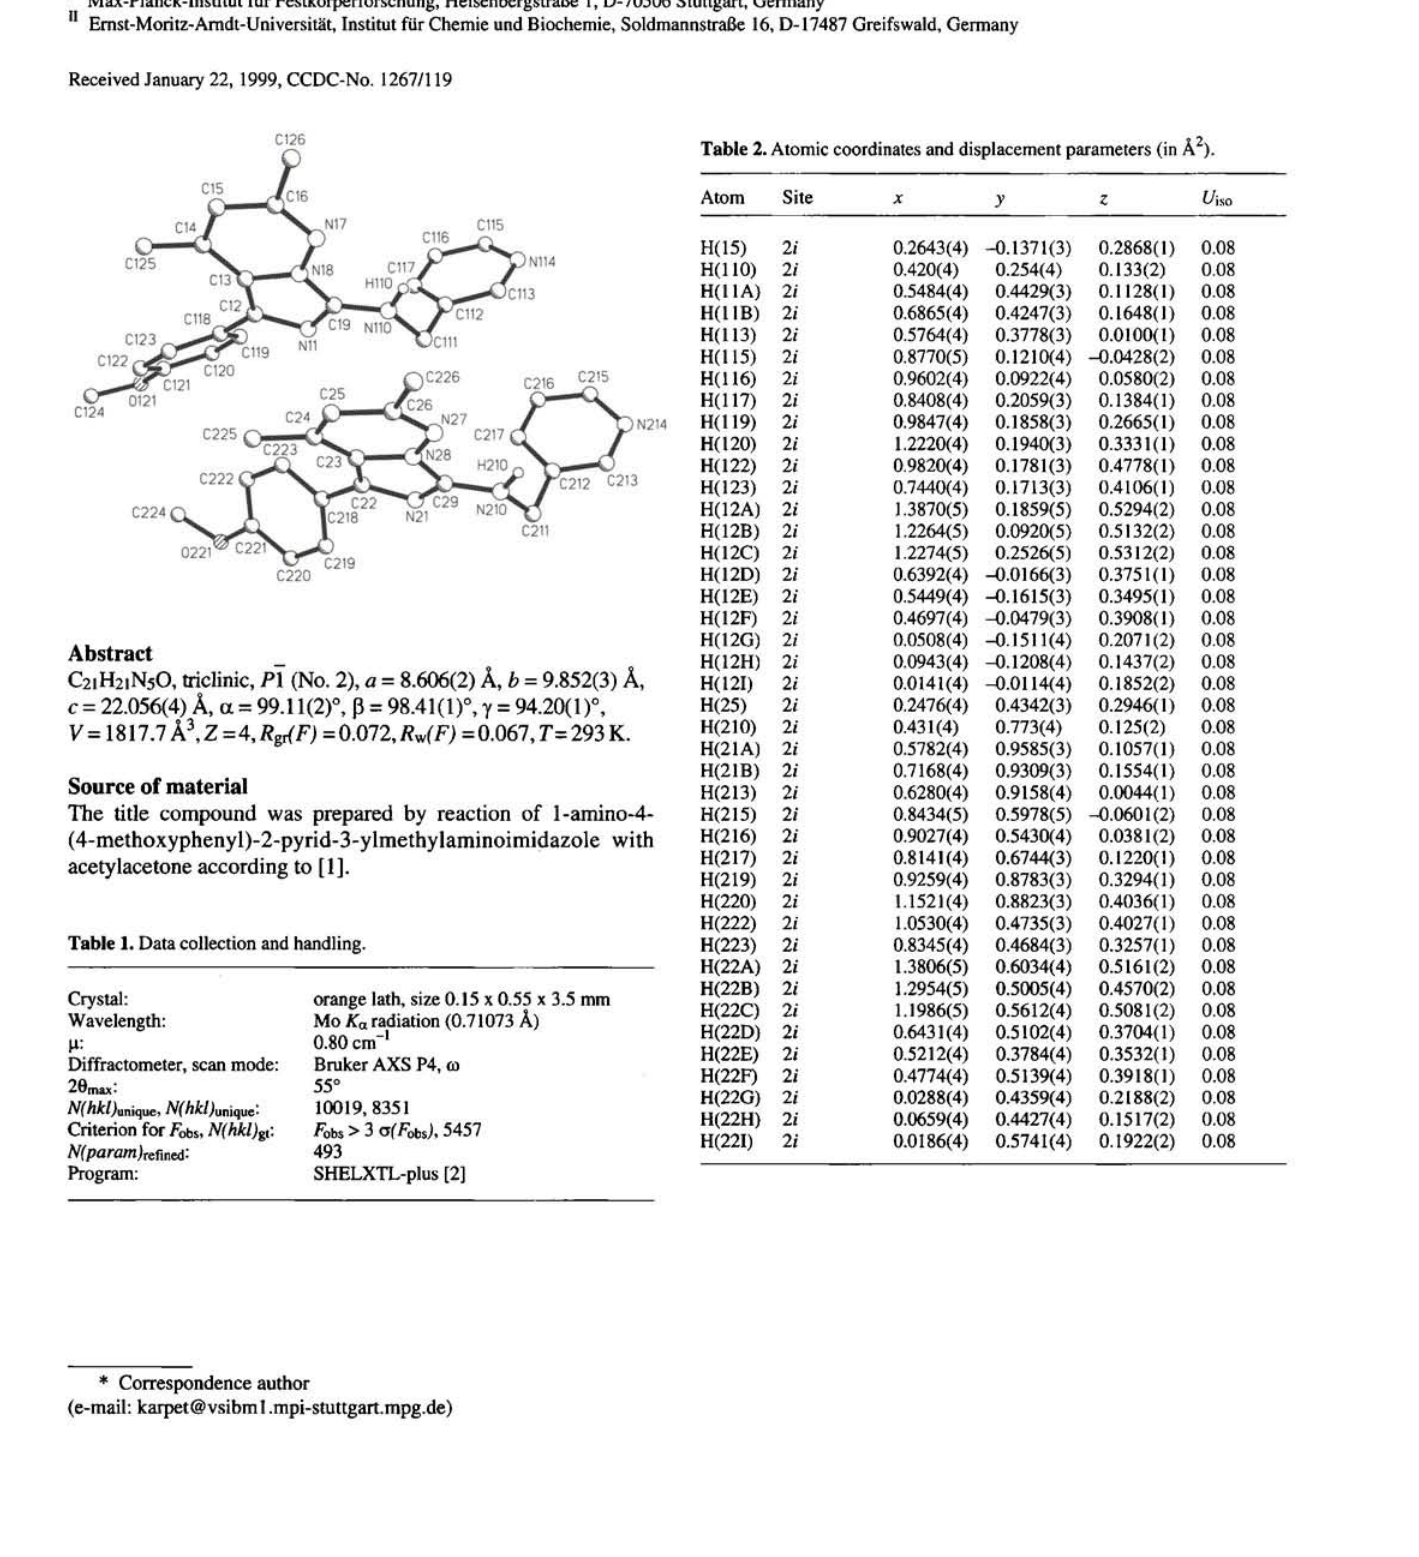
Table 2. Atomic coordinates and displacement parameters (in Â 2 ).